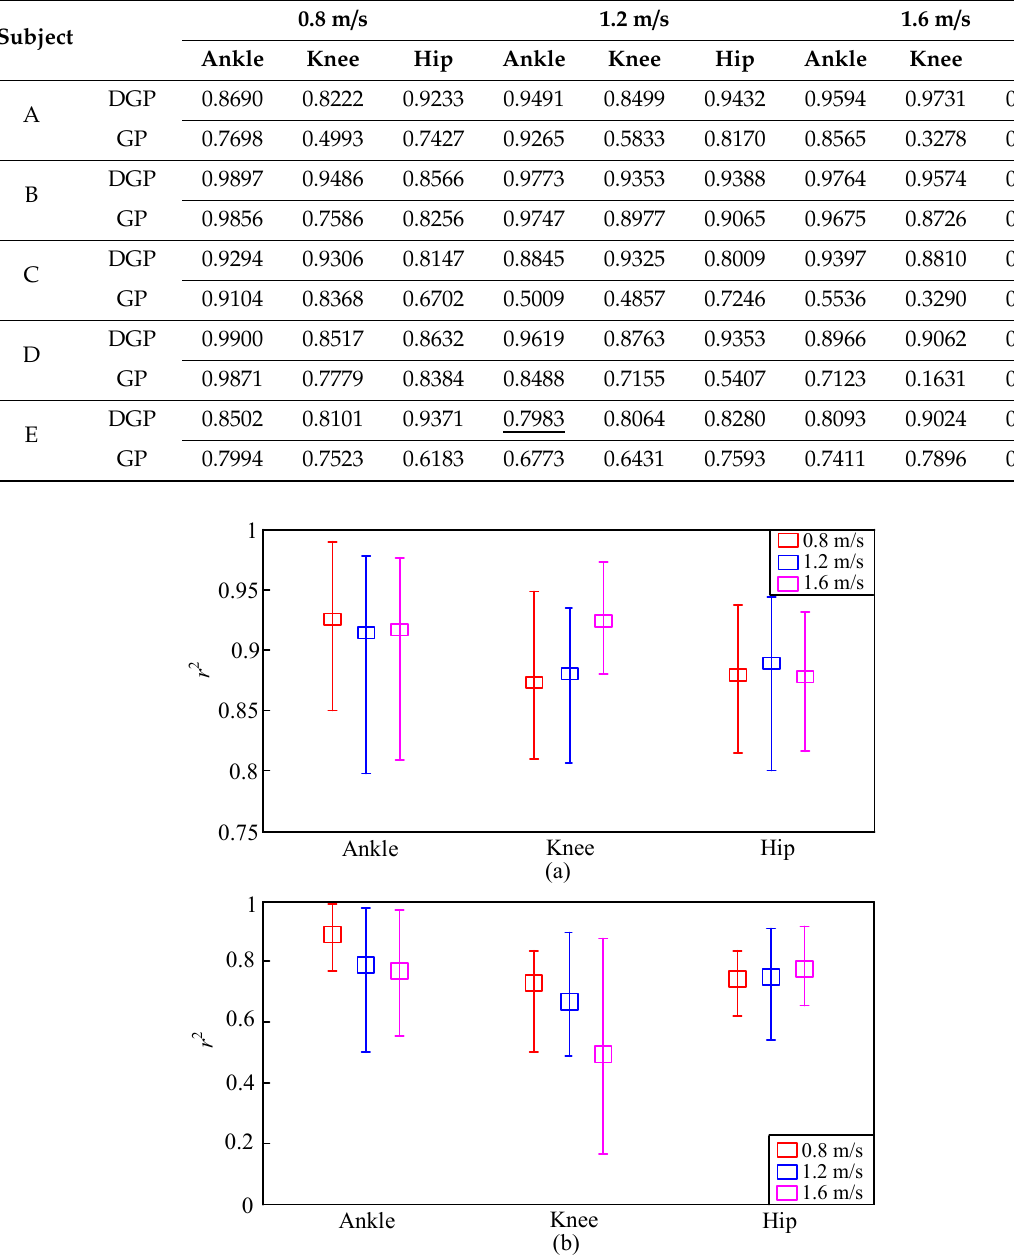
Table 3. r 2 values relating to three walking-speed levels. GP, Gaussian process.